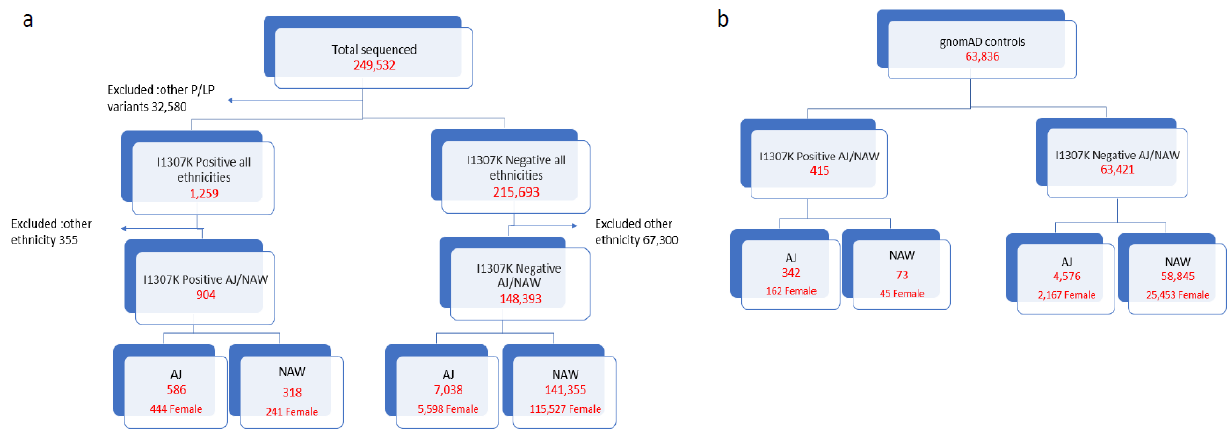
Figure 1. ( a ) Study group (cancer patients); ( b ) control group (individuals from gnomAD 2.1 — non-cancer).